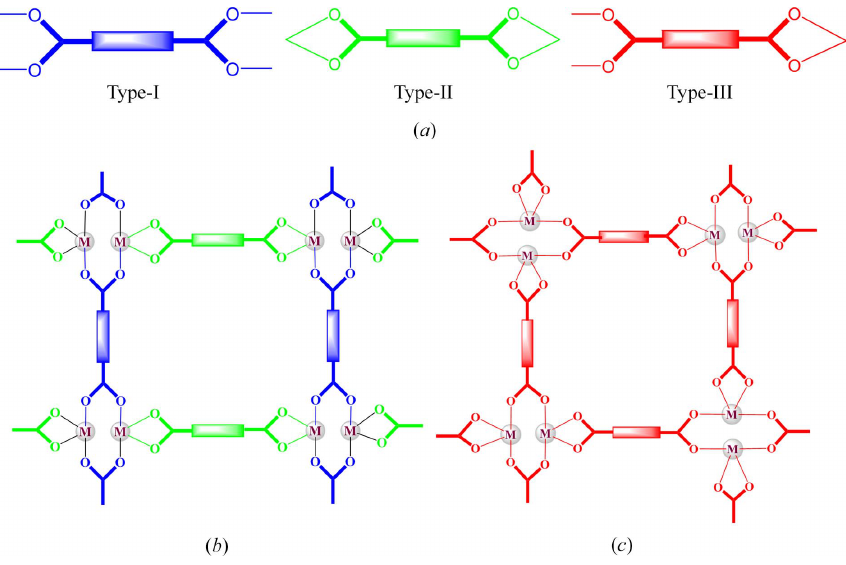
Figure 1 ( a ) Three types of connectivities of bdc in the chelating and bridging modes. Two structural isomers in the double-pillared-layer structure [ M 2 (dicarboxylate) 2 (pillar) 2 ]. ( b ) The (4,4) ‘rectangular’ net has an idealized local mm symmetry with type-I and type-II linkages. ( c ) The (4,4) ‘square’ net has an idealized local fourfold rotational symmetry with type-III connectivity of dicarboxylates. A rhombus-shaped net is also possible for type-III linkages. The axial positions are occupied by dipyridyl pillar ligands, which have been omitted for